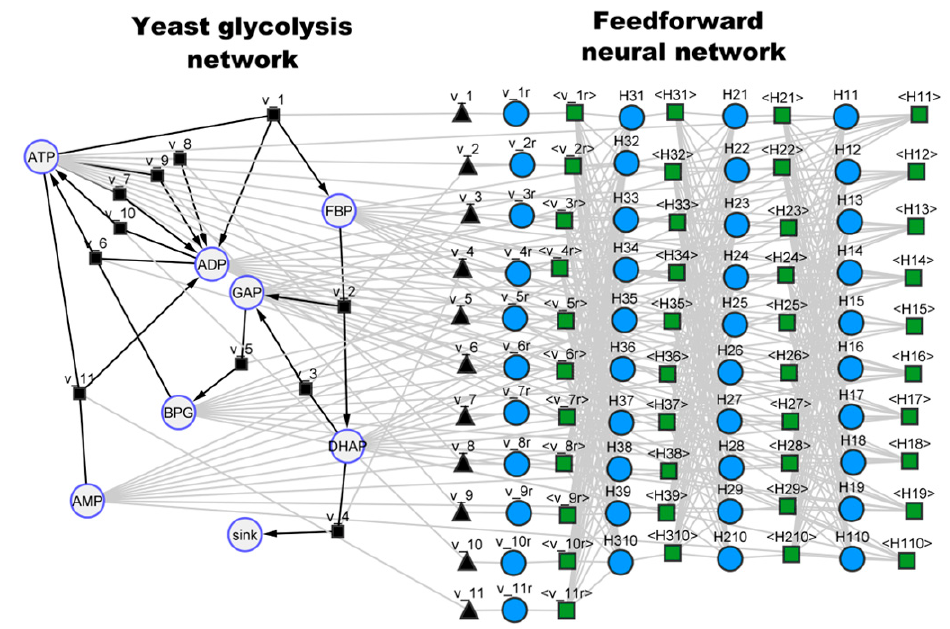
Figure 6. Hybrid model structure [7 × 10 × 10 × 10 × 11] for the yeast glycolysis pathway (6th row of Table 3) visualized in the cy3sbml tool [43]. Left side : Reduced glycolysis network with physical meaning. Large circles represent biochemical species (metabolites). Black squares and black edges represent biochemical reactions. Black triangles represent kinetic laws. Right side : Artificial feedforward neural network with size [7 × 10 × 10 × 10 × 11]. Small blue circles represent neural network nodes. Green squares and gray edges represent signal propagation between neural network nodes. The first layer receives input signals of biochemical species concentrations (Large circles). The last layer delivers kinetic parameter values to the black triangles, which mediate the communication between both sides of the network.